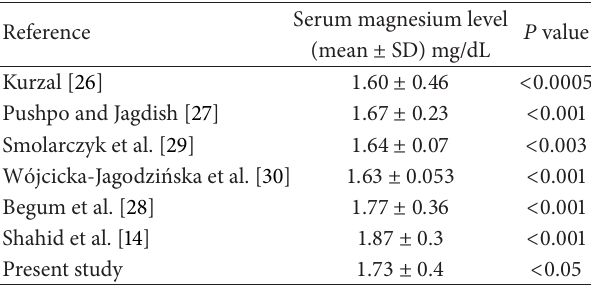
Table 4: Comparison of the previous studies on serum magnesium level in preterm labour with the current study [14, 26–30].